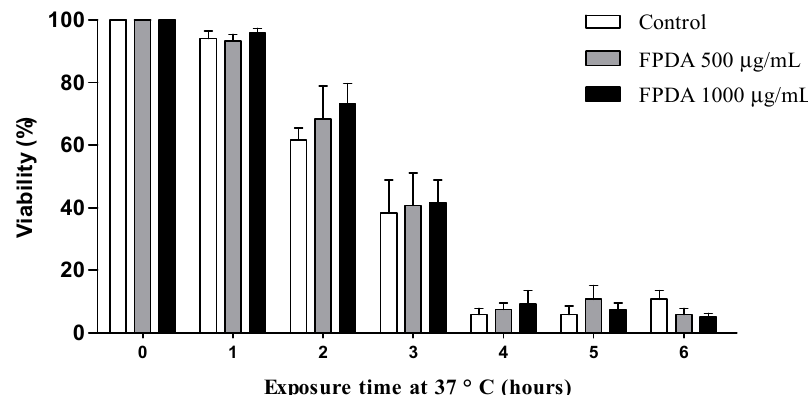
Figure 4. Thermal stress in the in vivo experimental model C. elegans subjected to treatment with FPDA. Values are expressed as the mean ± SEM.